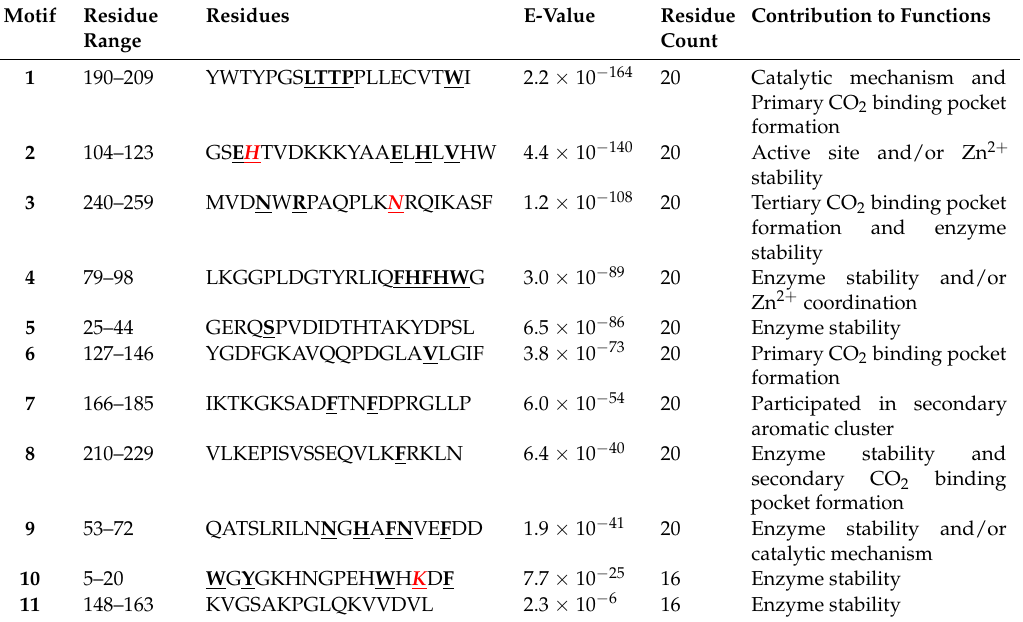
Table 2. Starting and ending positions of conserved motifs in CA-II, associated E-values and motif contribution to function. Residues from Table S1 are underlined and highlighted in bold. SNV positions (K18E, K18Q, H107Y and N252D) are underlined, italicized and presented in bold